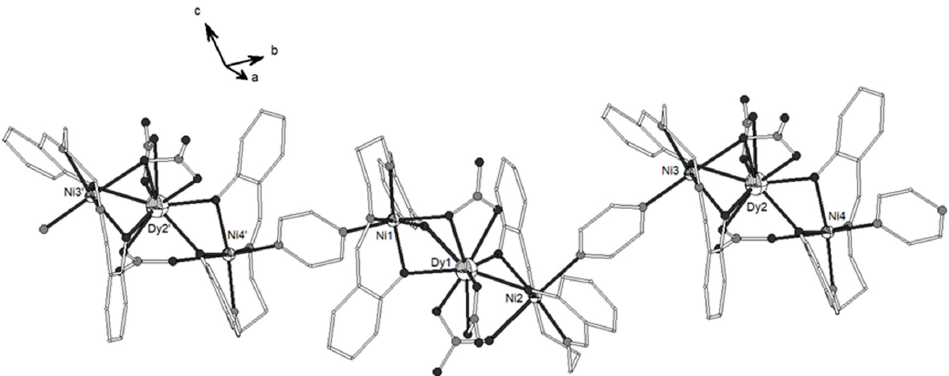
Figure 19. Part of the 1D structure of 164 . Primed atoms are generated by symmetry (‘) − 1 + x , − 1 + y , z . Color code: Ln large octant, Ni small octant, N light grey, O dark grey, C open small [57]. [{(NiL 24 ) 2 Dy(H 2 O) 4 (oxy-bbz)}(NO 3 )] n 165 (oxy-bbz = the dianion of 4,4 ′ -oxy-bis(benzoic) acid) [58]. The